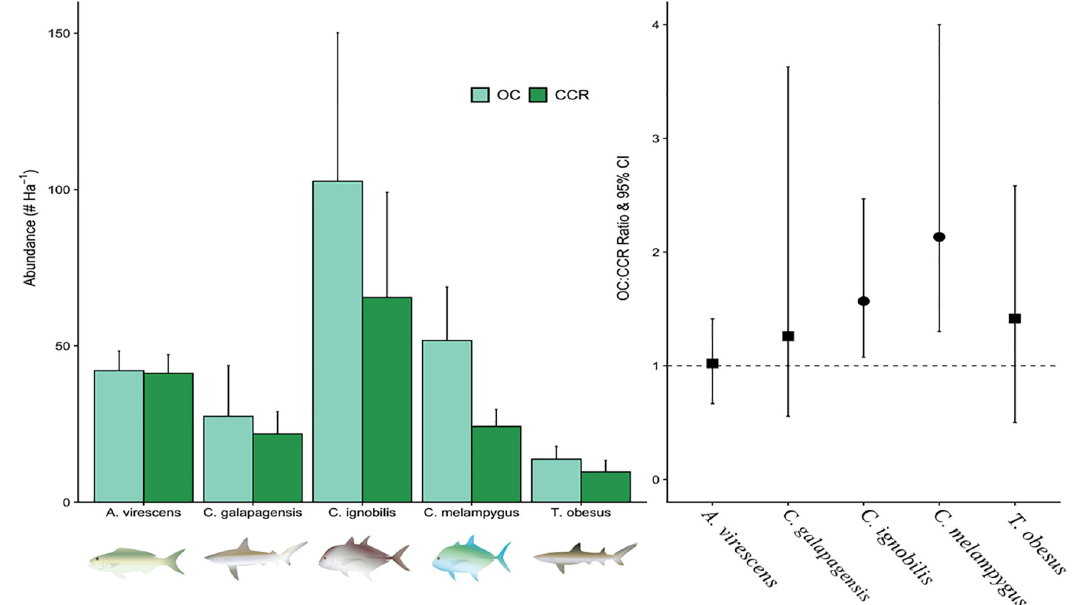
Fig 2. Abundance of fish species between gear types. Densities per species and relative abundance on open circuit SCUBA (OC) and closed-circuit rebreather (CCR). The left hand figure shows mean and standard error of abundance per species. The right hand figure represent the mean and 95% confidence intervals of the OC:CCR ratio (i.e. abundance in OC surveys relative to abundance in CCR surveys). Mean values above 100% indicate higher counts on OC. Ratios are considered significant when the 95% confidence intervals of the ratio do not overlap the 100%